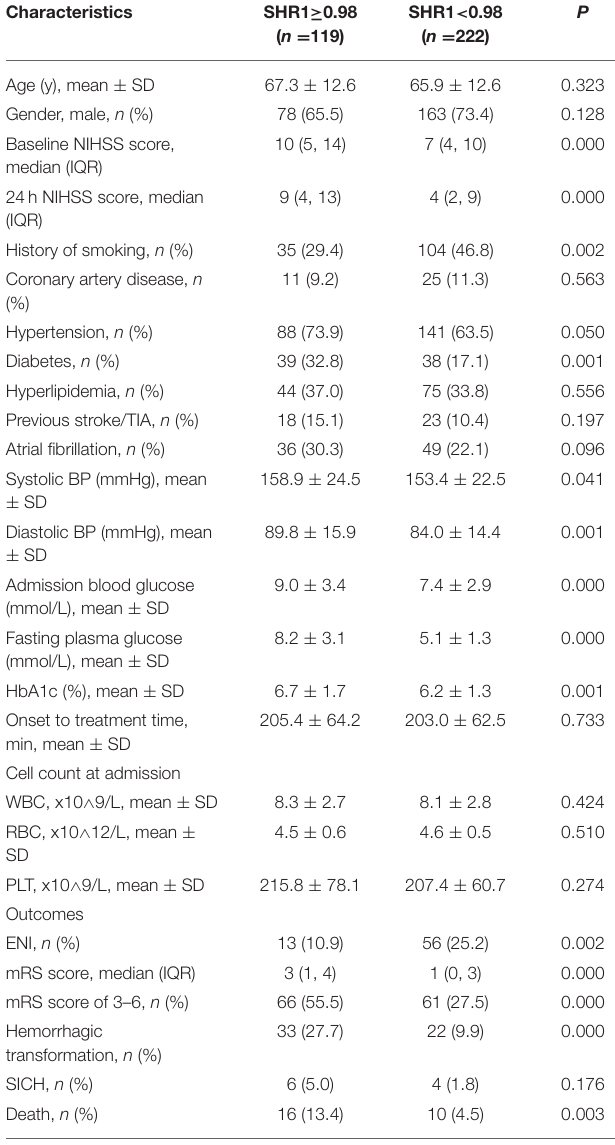
TABLE 2 | Receiver operating characteristic curves, identifying the predictive value of admission blood glucose, fasting plasma glucose, HbA1c, and SHR for poor outcomes at 3 months.